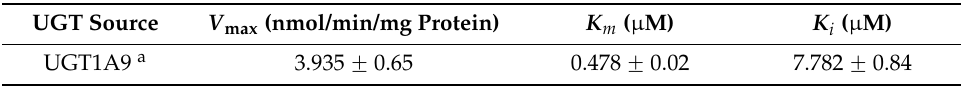
Table 2. Kinetic profiles of resveratrol on glucuronide formation from apigenin by recombinant UGT1A9. V max , K m , and K i values were expressed as best-fit values ˘ SEM of the estimate and were representative of triplicate